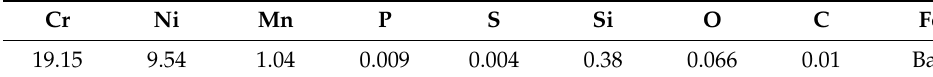
Table 1. Elemental components of 304L SS powder (wt.%).